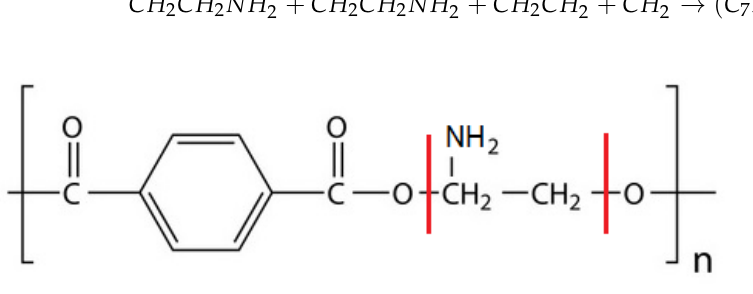
Figure 9. Proposed molecular structure of PET after the plasma treatment .